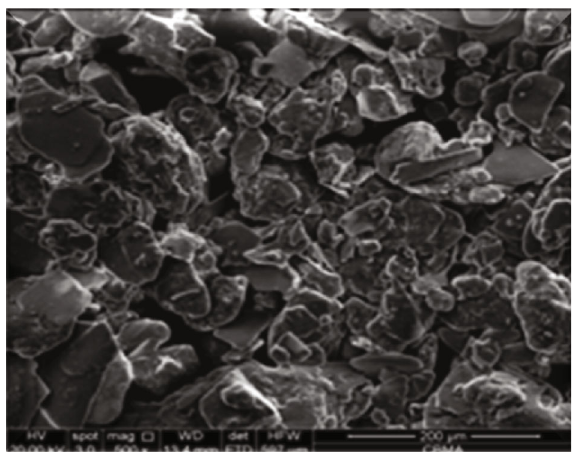
Figure 1: Microstructure of the HS